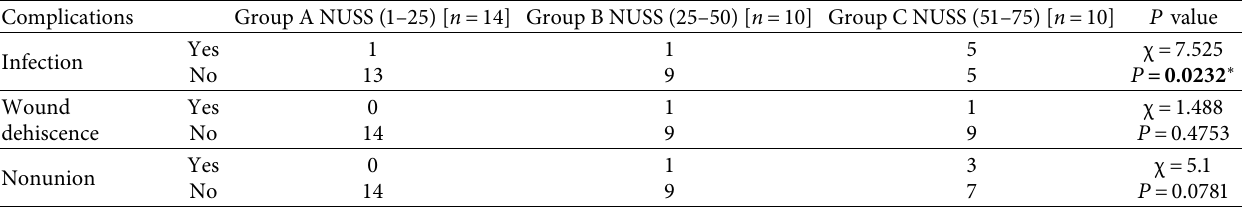
Table 5: Complications.